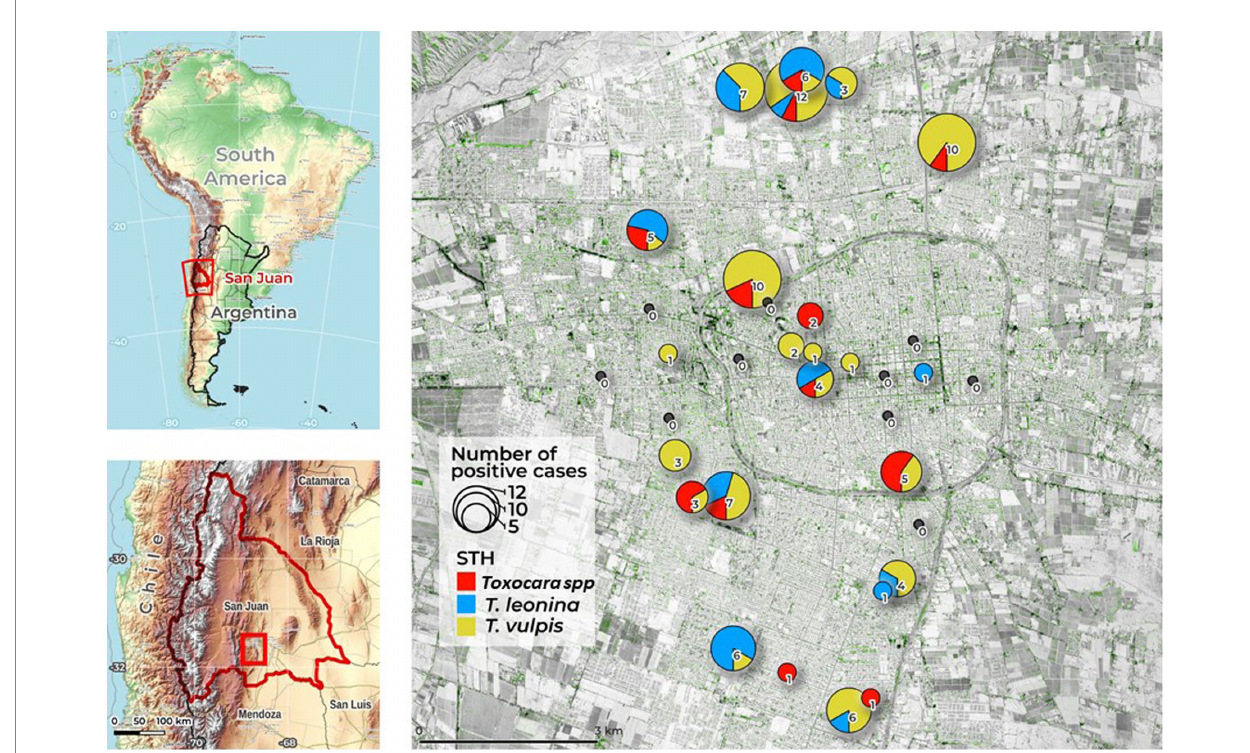
FIGURE 1 Study area of San Juan City (San Juan, Argentina) in the context of South America. Main Map: Cumulative number of canine soil-transmitted helminths (cSTH) found in each sampling location (2021–2022) by species. Map backgrounds: main map from ©2022 Google; inset map from ©OpenStreetMap, ©OpenTopoMap (CC-BY-SA). Map data: August 09,